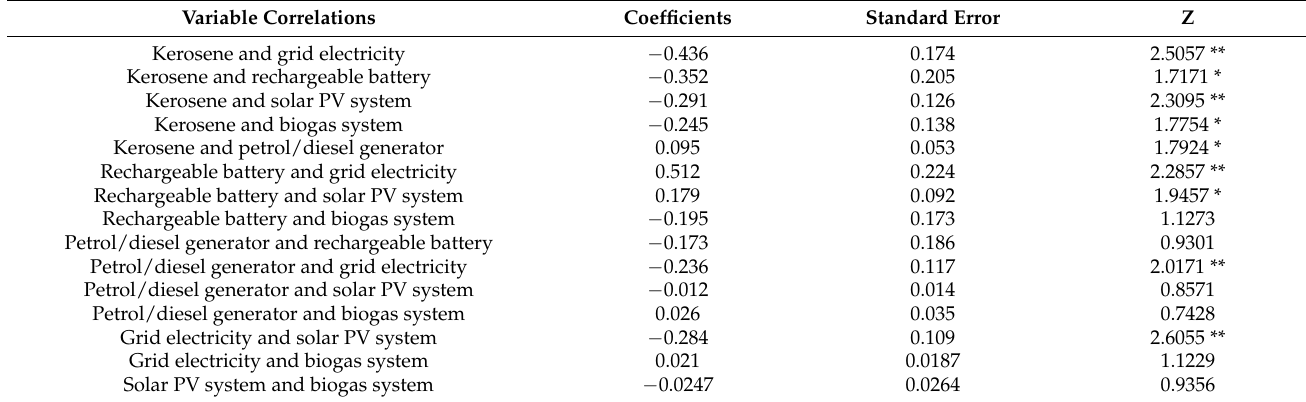
Table 6. Correlation coefficients of the six lighting energy